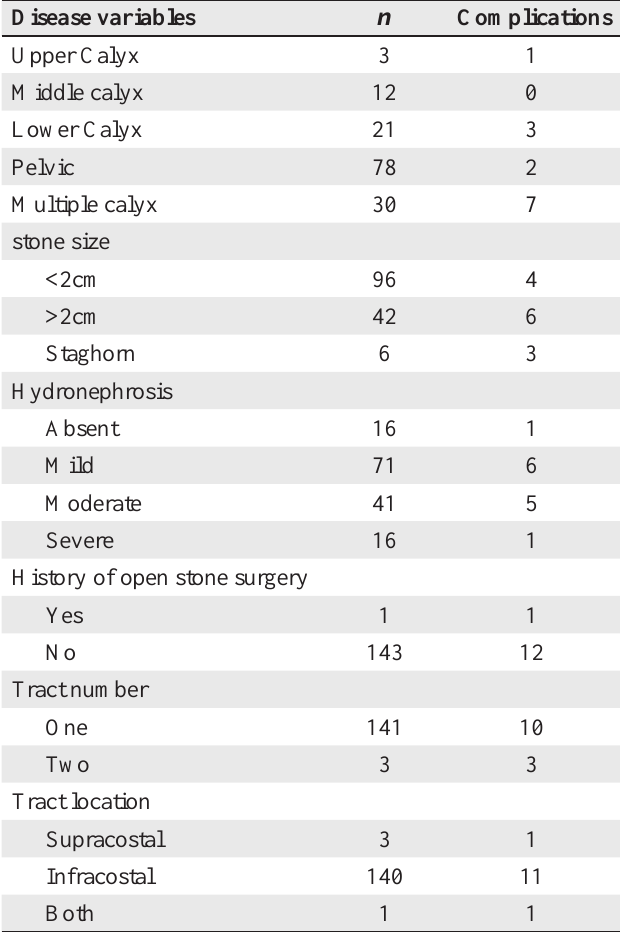
Table 1 : Disease variables and